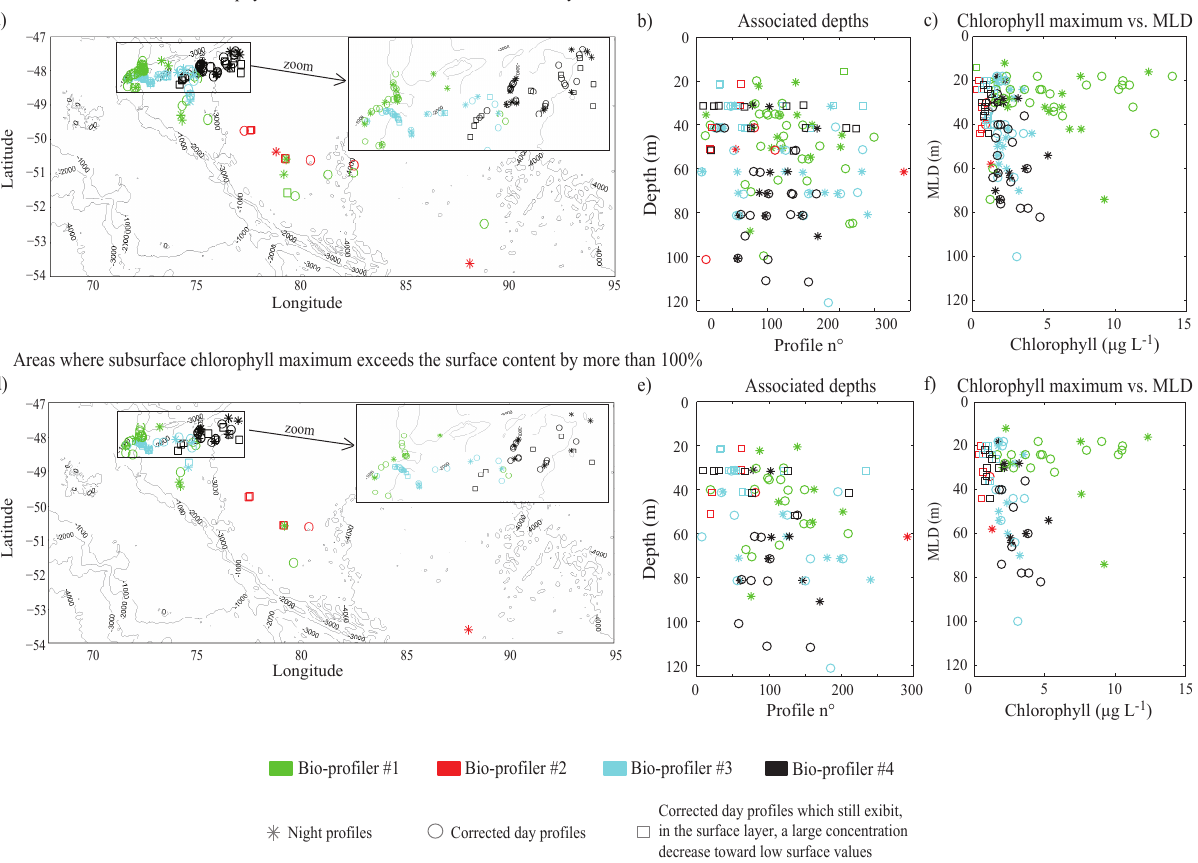
Figure 7. Characteristics of subsurface chlorophyll maxima occurring at depths greater than the mixed layer depth and exceeding the surface content by more than 60% (top) and 100% (bottom). (a, d) Geographical areas where these subsurface Chl a maxima occur with an expanded view for the Gallieni Spur region. (b, e) Associated depths of these subsurface Chl a maxima along the bio-profiler trajectories (i.e. vs. profile numbers). (c, f) Relationship between the amplitude of these Chl a maxima (in µgL − 1 ) and the mixed layer depth (MLD, in m). Symbols: stars refer to night profiles, circles to day profiles, and squares to flagged day profiles (i.e. which still exhibit, in the surface layer, a large concentration decrease toward low surface values that indicates the possibility of incomplete quenching correction; see definition in the caption of Fig.